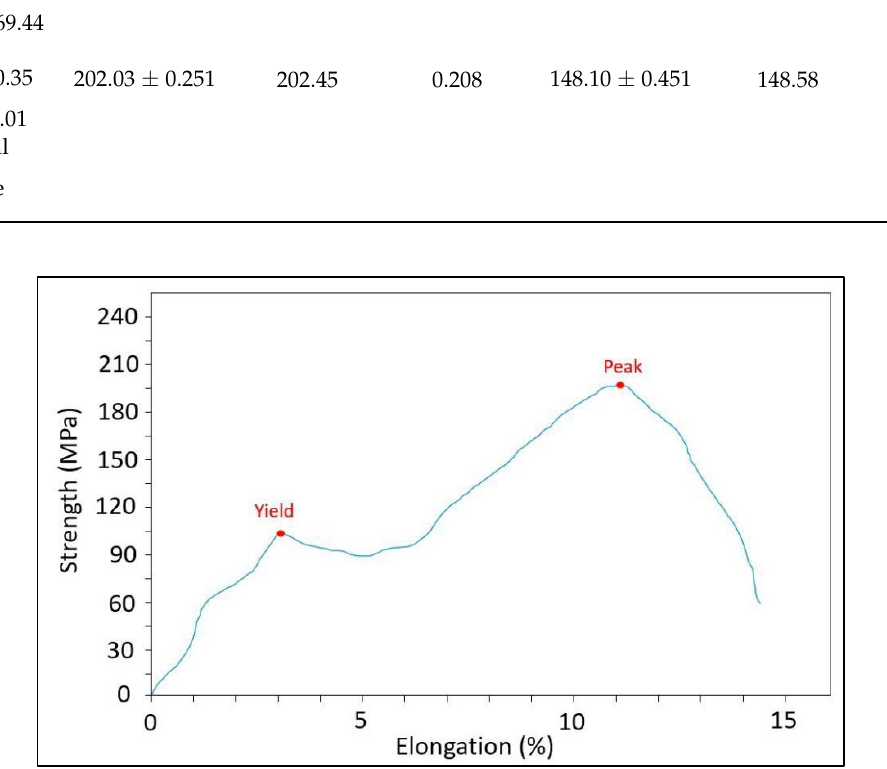
Table 13. Comparison of the experimental and the MOVaNSAS results.